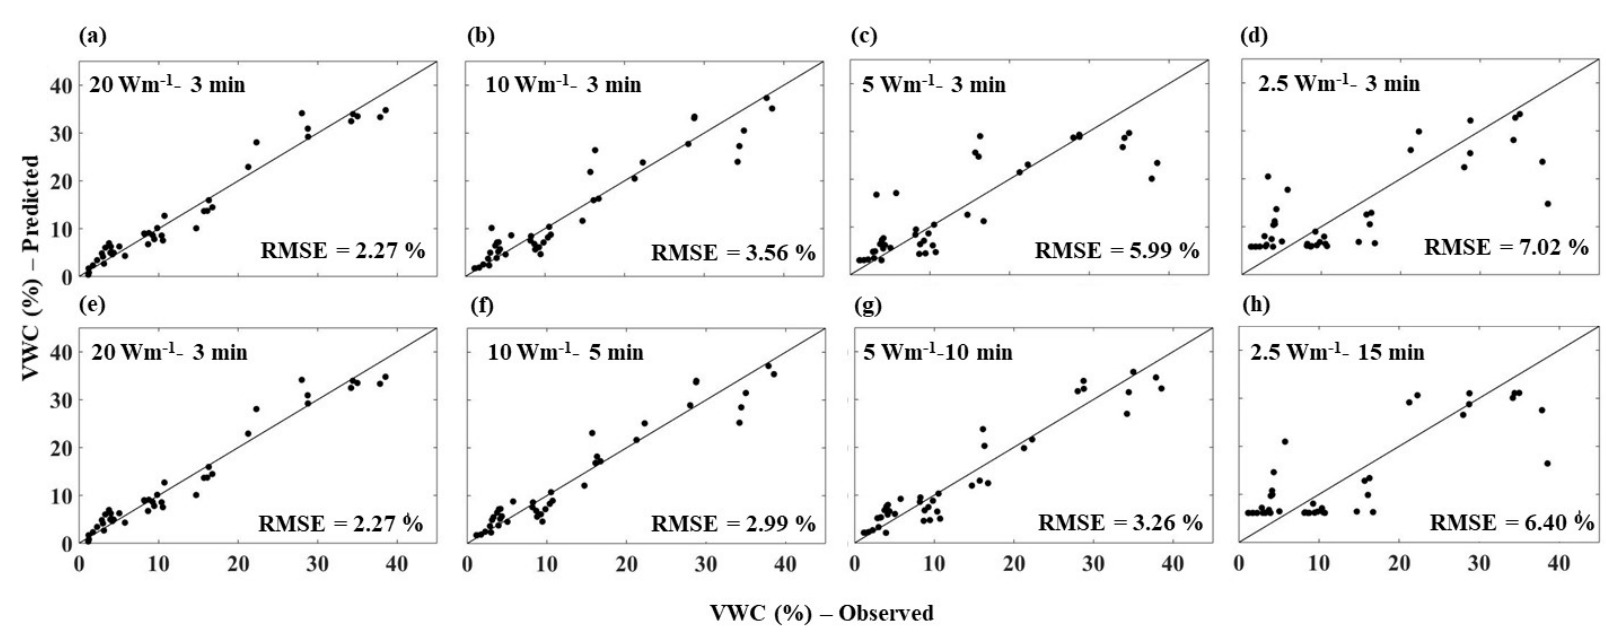
Figure 9. Comparison between AHFO predicted and observed (gravimetric method) soil water content of sandy loam soil for all the heating strategies. Note: ( a ) and ( e ) are similar (20 Wm − 1 –3 min) and are used to compare with the short pulses (along row 1) and with the long pulses (along row 2).